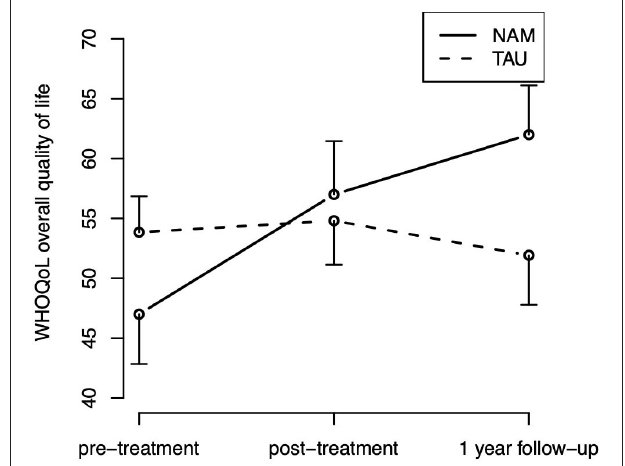
FIGURE 3 | BDI-II time course by treatment group (means and standard errors).